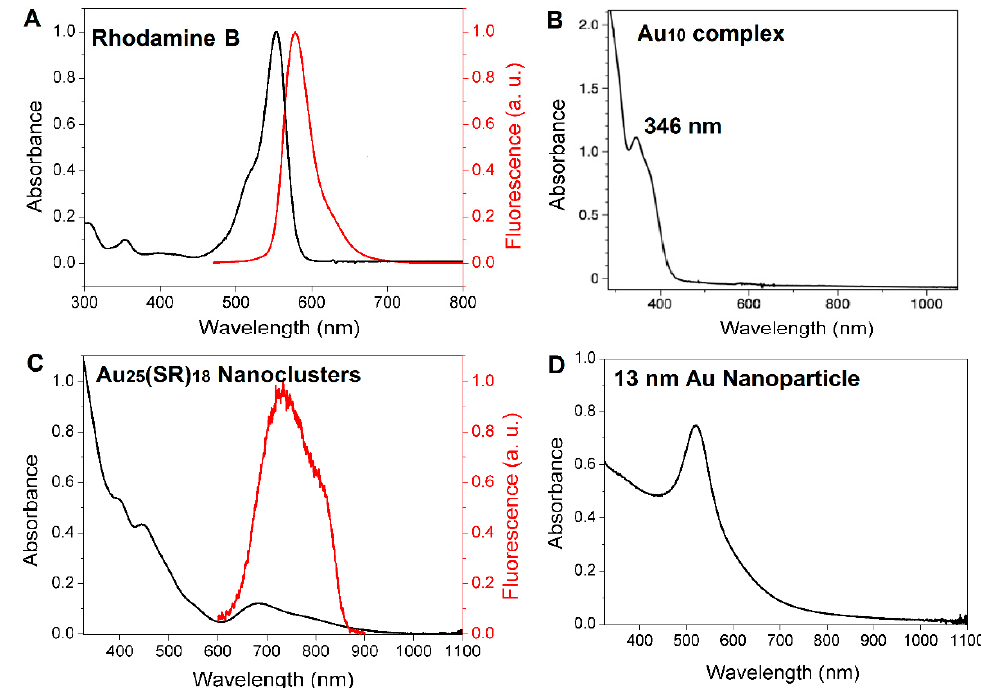
Figure 2. Steady-state optical spectra of ( A ) Rhodamine B; ( B ) complex Au 10 (SR) 10 ; ( C ) nanocluster Au 25 (SR) 18 , and ( D ) 13 nm diameter Au nanoparticles.